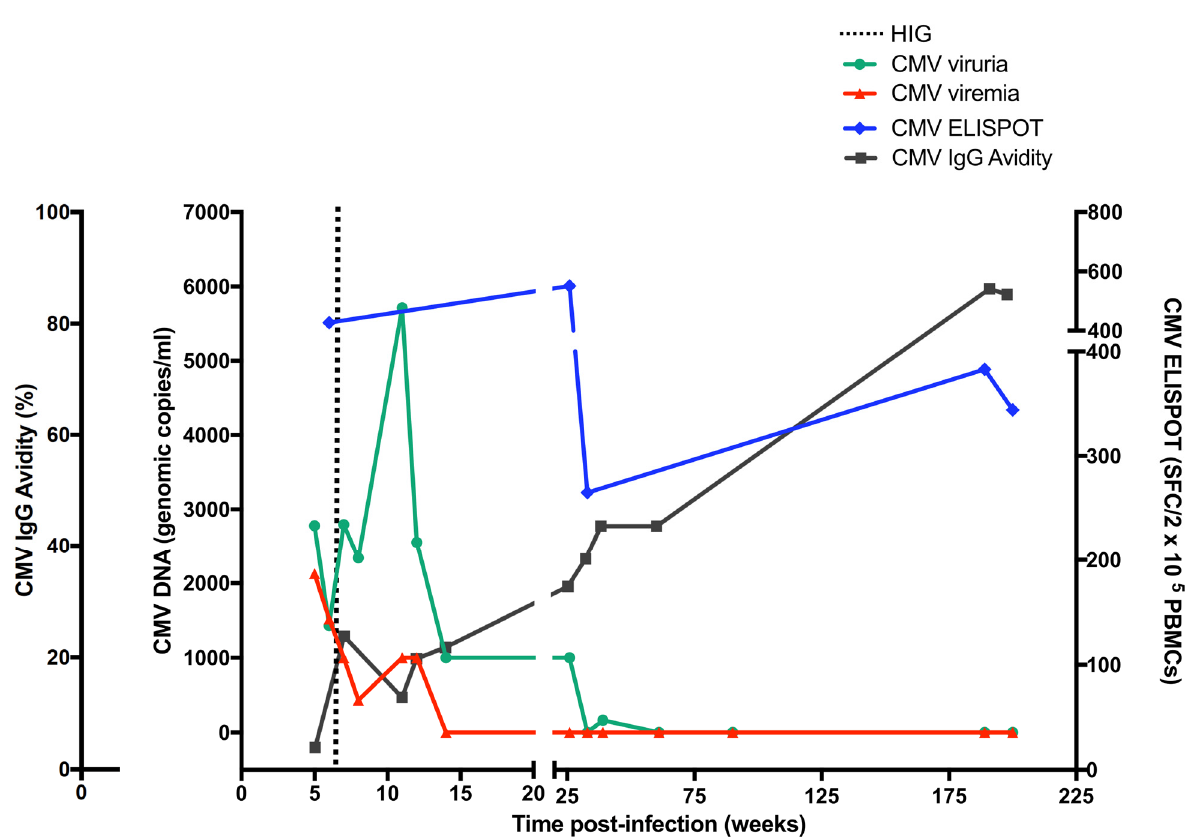
Figure 1. Prospective follow-up pattern of the CMV specific T-cell mediated-immunity (CMV-EliSpot), CMV IgG avidity, CMV viremia and viruria in a pregnant woman experiencing primary CMV infection. CMV